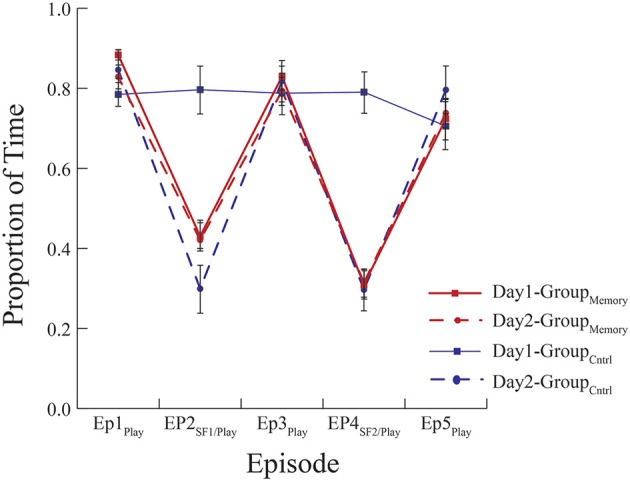
Mean proportion of time infants spent looking at their mother. GroupMemory infants spent less time looking at their mothers during the SF episodes on Day 1 and Day 2. GroupControl infants behaved similarly in response to their first exposure to the FFSF on Day 2. There were no differences in behavior indicative of memory between infants' first and second exposures to the FFSF paradigm.